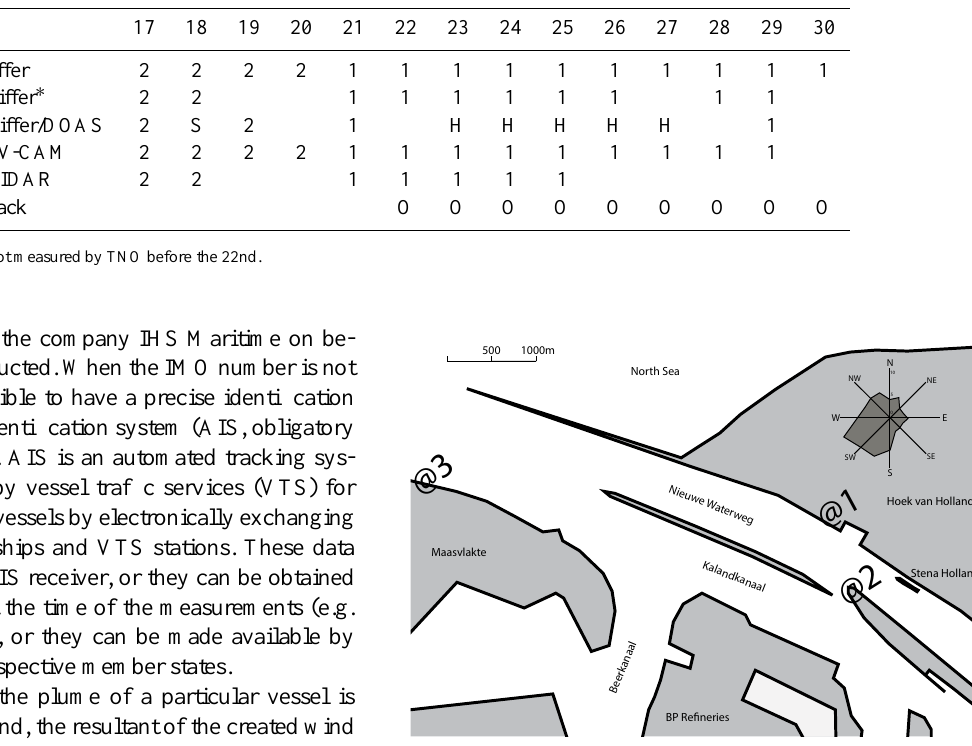
Figure 1. Scheme of the entrance of the port of Rotterdam and the three measurements points used during the SIRENAS-R campaign (@1=Hoek van Holland, @2=Landtong, @3=Maasvlakte). The berth position of Stena Hollandica and the average wind direction (years 1999–2011) are also